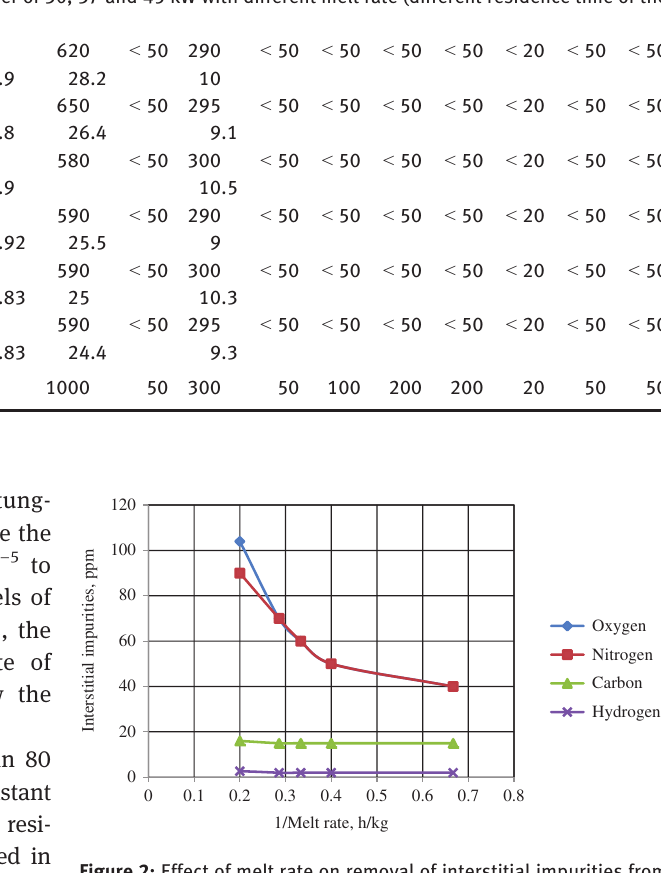
Figure 2. Similarly, the analyses of interstitial impurities present in EB melted Nb ingots of 60 mm diameter pro- duced at three power levels of 30, 37 and 45 kW (adopt- ing different melt rates for each power level) are presented in Figure 3. The analyses of interstitial impu- rities present in Nb ingots of 60 mm diameter produced at constant melt rate but with different beam power are presented in Figure 4.